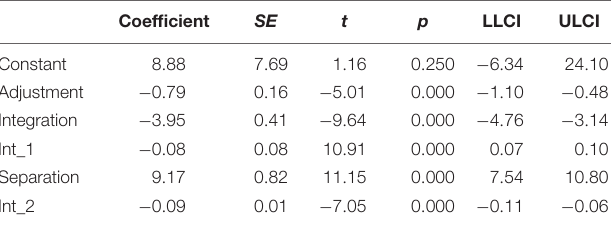
TABLE 15 | Moderation model with work-related anxiety as the dependent variable (StWE).